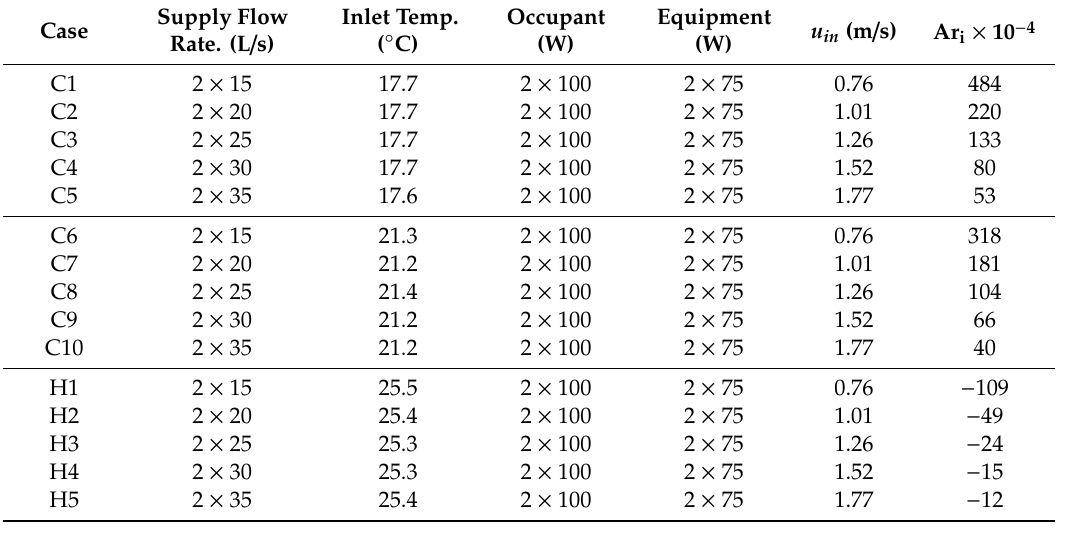
Table 1. Case conditions for di ff erent cases. Case C1–C10 represents cooling cases and H1–H5 represents heating cases.